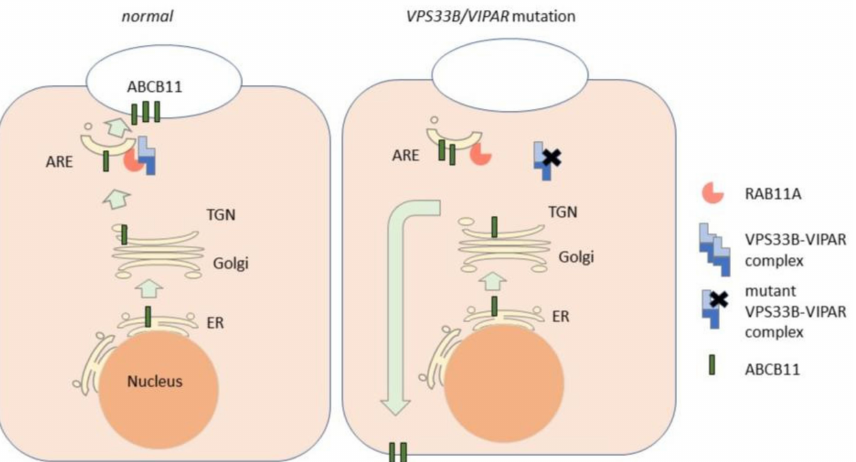
Figure 3. Cartoon depicting the role of the VPS33B/VIPAR complex and its mutations in the trafficking of ABCB11. In the normal situation (left), newly synthesized ABCB11 traffics via the endoplasmic reticulum (ER), the Golgi apparatus and the trans-Golgi network (TGN) to the apical recycling endosomes (ARE). From the ARE, ABCB11 is trafficked to the bile canalicular surface via a mechanism that involves the ARE-associated RAB11A and its interaction with the VPS33B/VIPAR complex. In the absence of mutated forms of VPS33B or VIPAR, the RAB11A–VPS33B/VIPAR complex cannot form, resulting in the impaired trafficking of ABCB11 to the canalicular surface and the mis-sorting of ABCB11 to the basolateral surface.